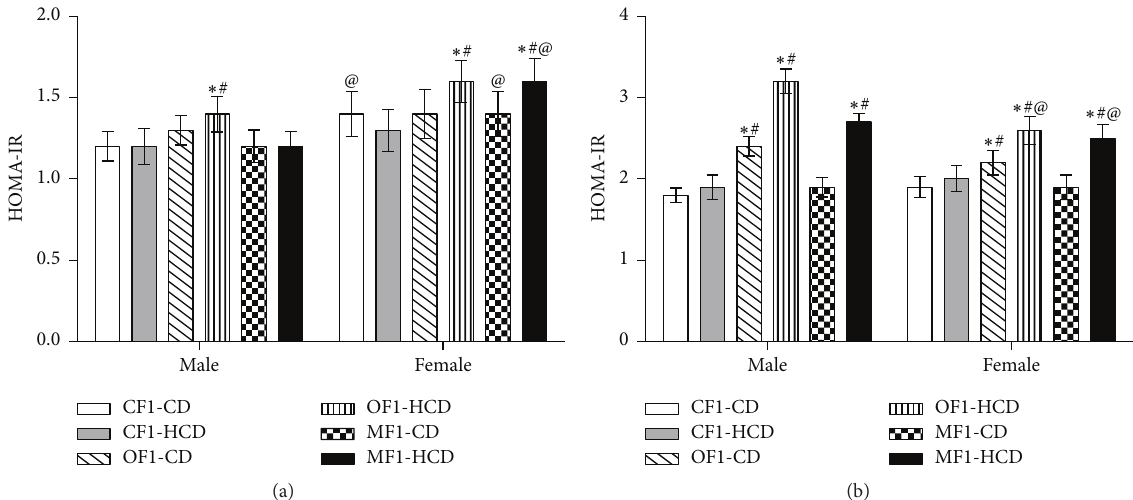
Figure 3: Homeostasis model assessment of insulin resistance (HOMA-IR) of all study groups at (a) week 5 and (b) week 30 of age. Data are presented as mean ± SD ( 𝑛 = 10 ). CF1-CD: F1 offspring of control mothers under control diet, CF1-HCD: F1 offspring of control mothers under high-caloric diet, OF1-CD: F1 offspring of obese mothers under control diet, and OF1-HCD: F1 offspring of obese mothers under high-caloric diet; MF1-CD: F1 offspring of malnourished mothers under control diet and MF1-HCD: F1 offspring of malnourished mothers under high-caloric diet. The symbol ∗ indicates significant difference from CF1-CD by ANOVA ( 𝑝 < 0.05 ), the symbol # indicates significant difference from CF-HCD by ANOVA ( 𝑝 < 0.05 ), and the symbol @ indicates significant difference from male at each age by 𝑡 -test.